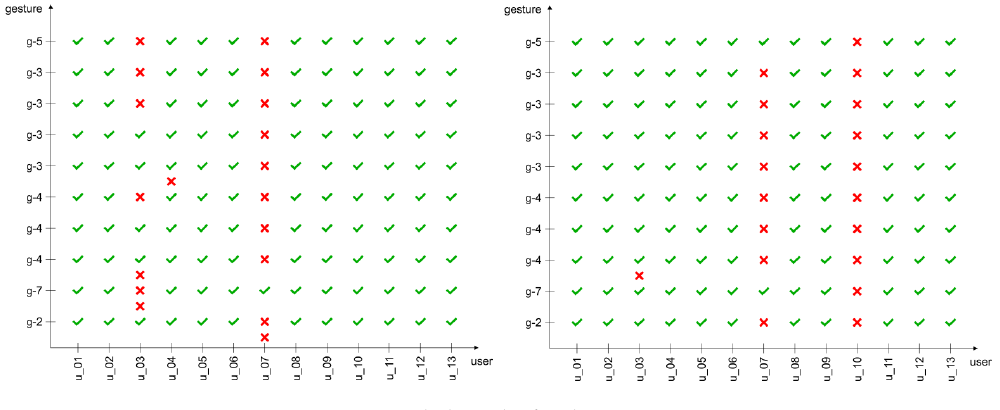
Figure 8. Detailed results for the S-4 scenario.